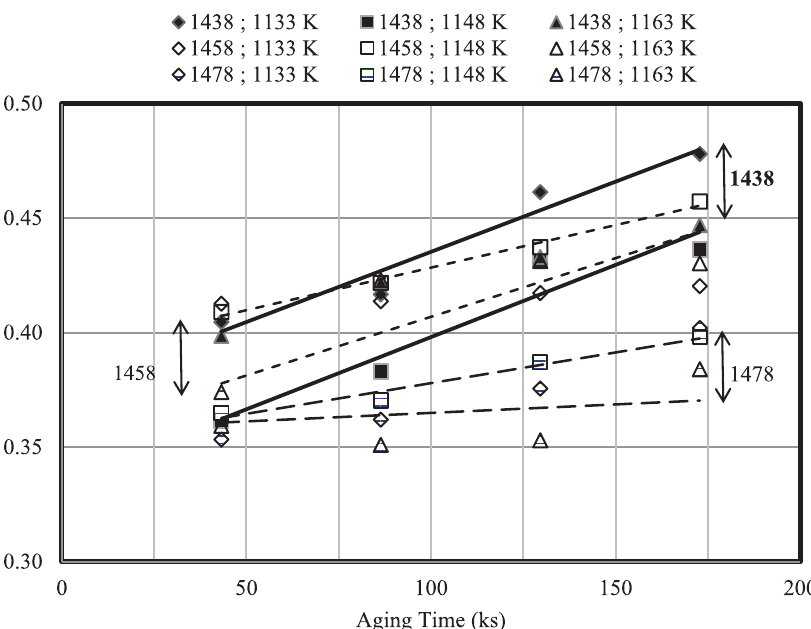
Fig. 5: Area fraction of γ ′ particles at various aging times of each aging temperature after solutionizing temperatures of 1,438, 1,458 and 1,478 K for 14.4 ks